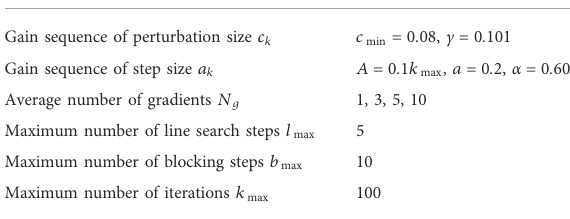
TABLE 2 The applied SPSA options for optimization.